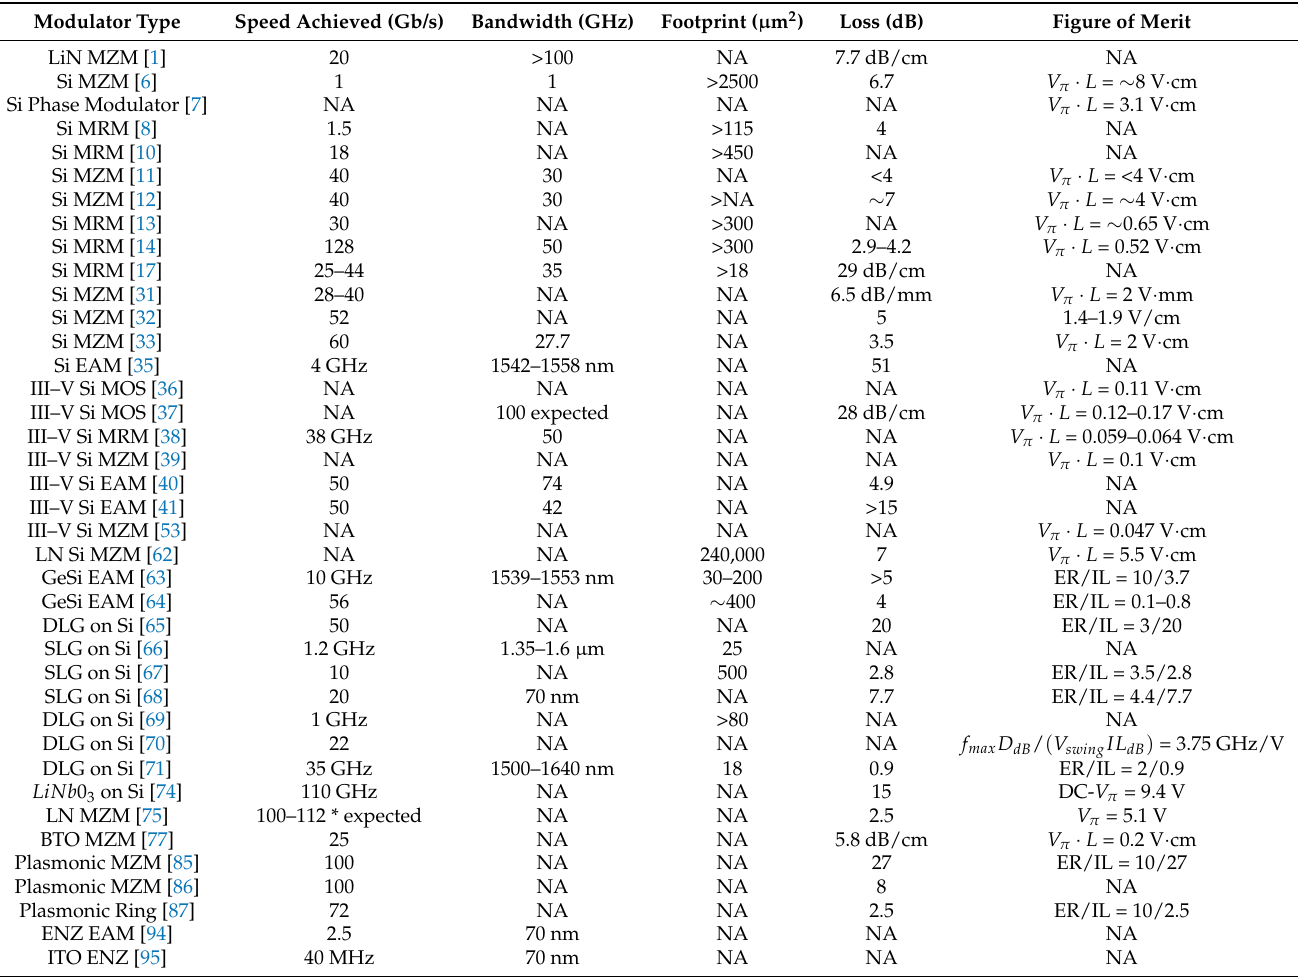
Table 1. A comparison table of noted figures of merit for the various state of the art devices researched for this paper. NA indicates that the desired quantity was not made available. * indicates the the value was simulated but not yet experimentally